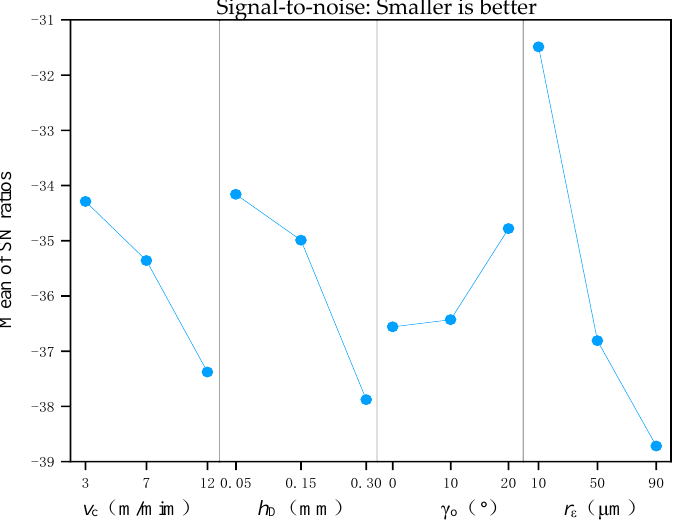
Figure 6. Signal-to-noise ratio of the cutting force in the cutting direction. The histogram of the signal-to-noise ratio of the cutting force along the vertical direction under different machining parameters is shown in Figure 7. According to the analysis method of Figure 6, the machining parameter combination of the minimum cutting force in the vertical direction can be obtained from the figure. Namely, the cutting speed is 7 m/min, the cutting thickness is 0.05 mm, the tool rake angle is 20 ◦ , and the rounded edge radius is 10 µ m. Signal-to-noise: Smaller is better